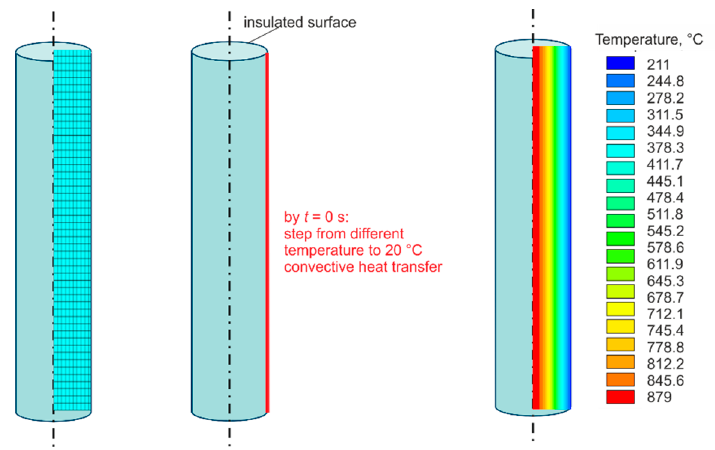
Figure 4. Finite element analysis (FEA) model, boundary condition, and an example of typical temperature gradient field.